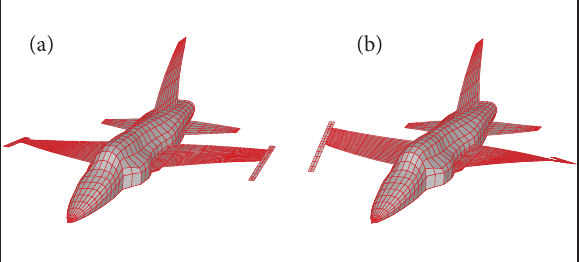
Figure 7. Mode shapes involved in coupling mechanism. (a) 5 th mode vertical fin bending — 15.10 Hz; (b) 7 th mode antisymmetric wing torsion — 16.70 Hz.